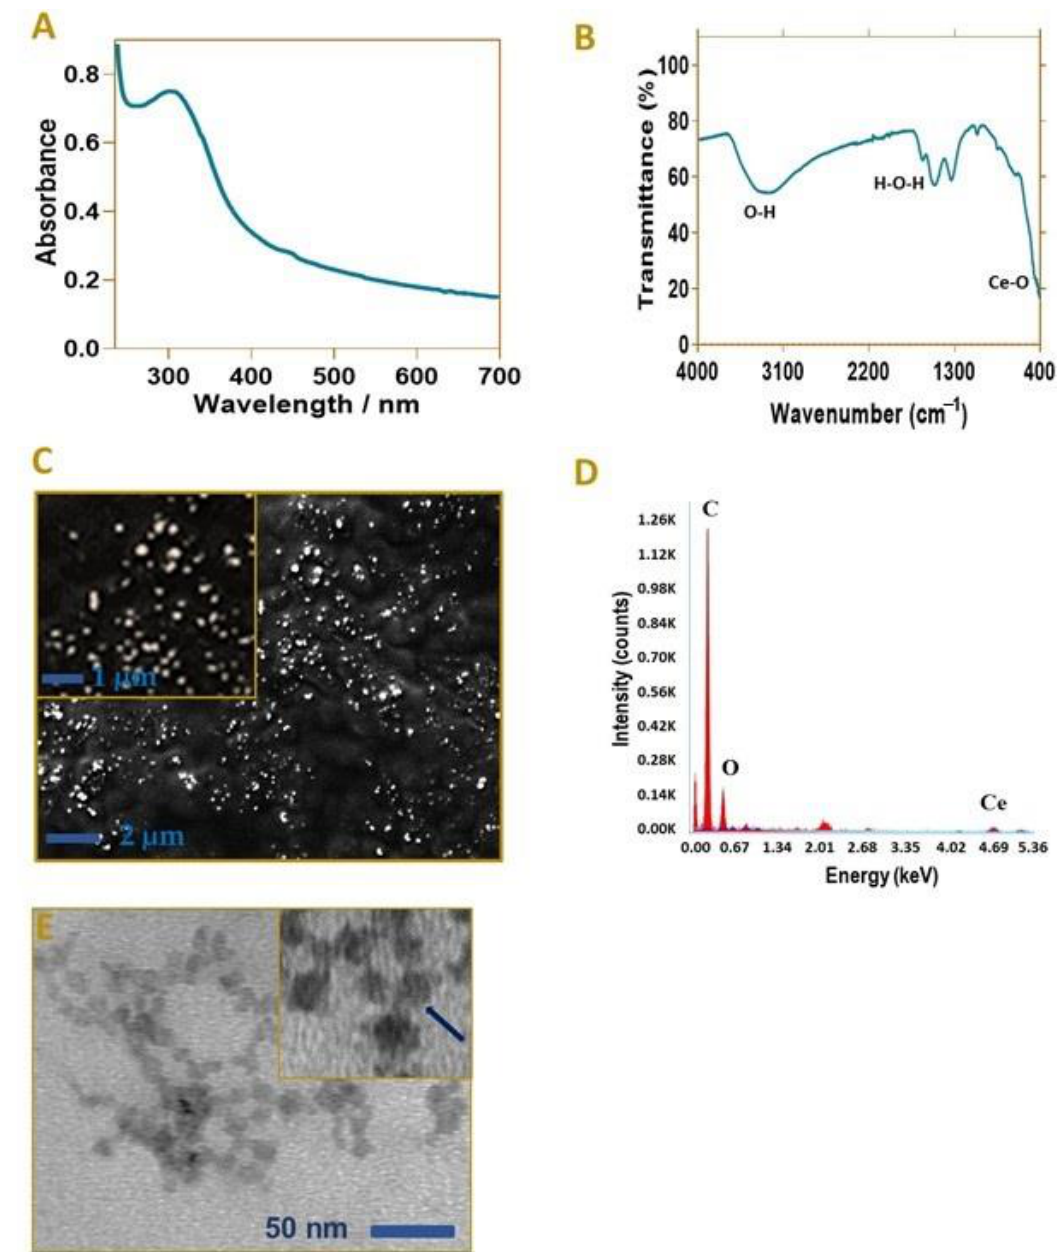
Figure 1. Nanoceria characterization by ( A ) UV-spectra of nanoceria, ( B ) FT-IR (4000-400 cm −1 ), ( C ) SEM, ( D ) EDX, and ( E ) TEM micrograph displays spherical-ovoid shaped nCeO 2